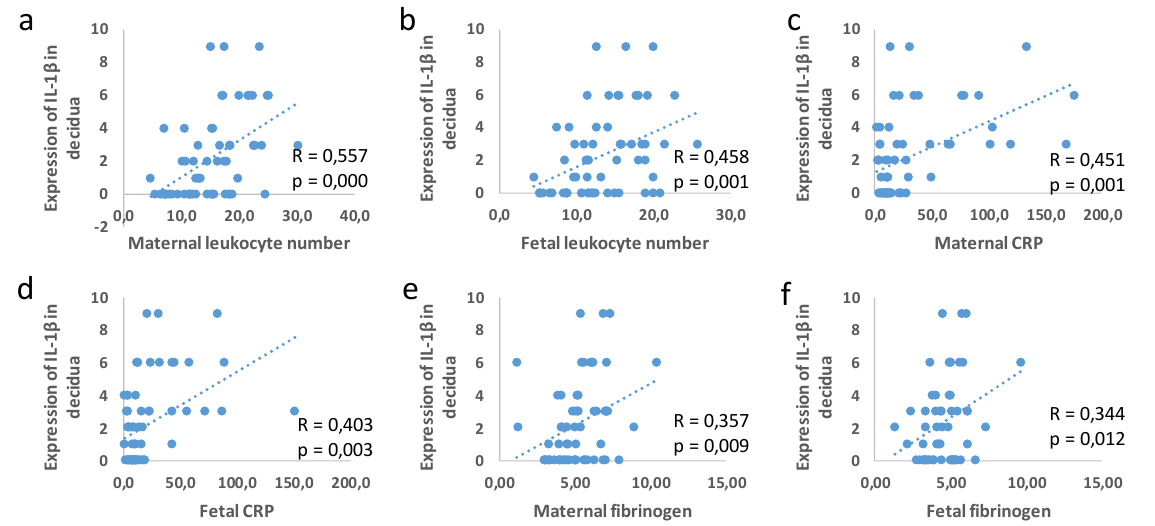
Figure 9. Correlation in expression of IL-1 β in decidua and leukocyte number in maternal blood ( a ), leukocyte number in fetal blood ( b ), maternal levels of CRP ( c ), fetal levels of CRP ( d ), maternal fibrinogen ( e ), fetal levels of fibrinogen ( f ).